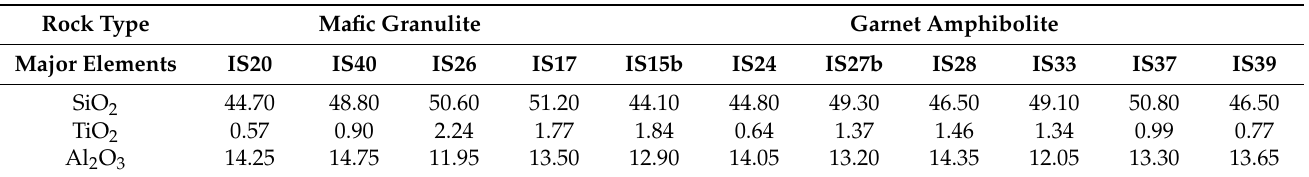
Table 1. Major elements (wt%) and trace elements (ppm) compositions of the Anyouzok metavolcanic